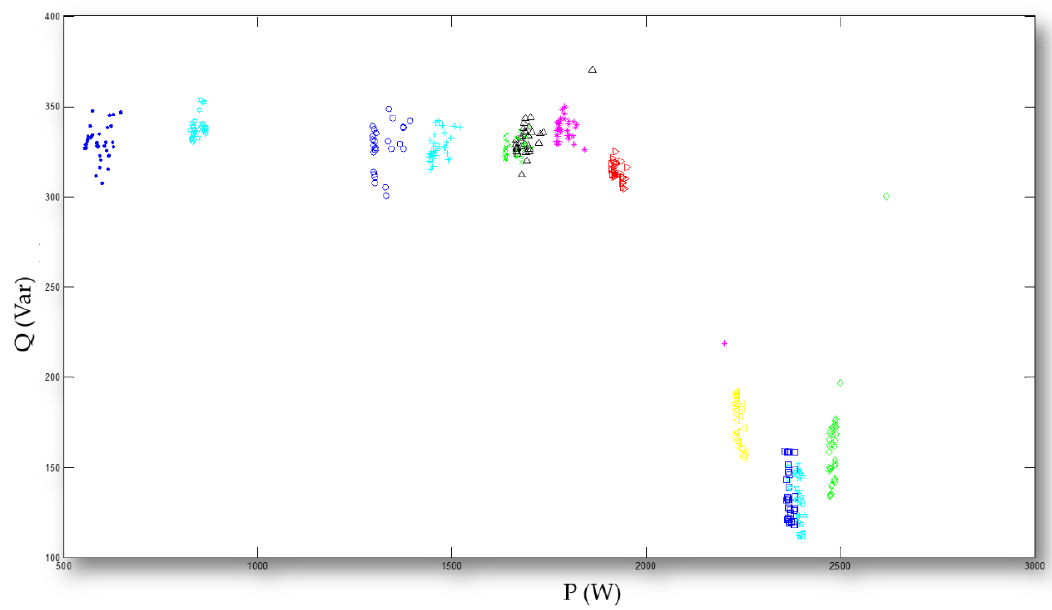
Figure 9. Experimental set-up of the home energy management systems (HEMS) [24] with the NILM in this work.